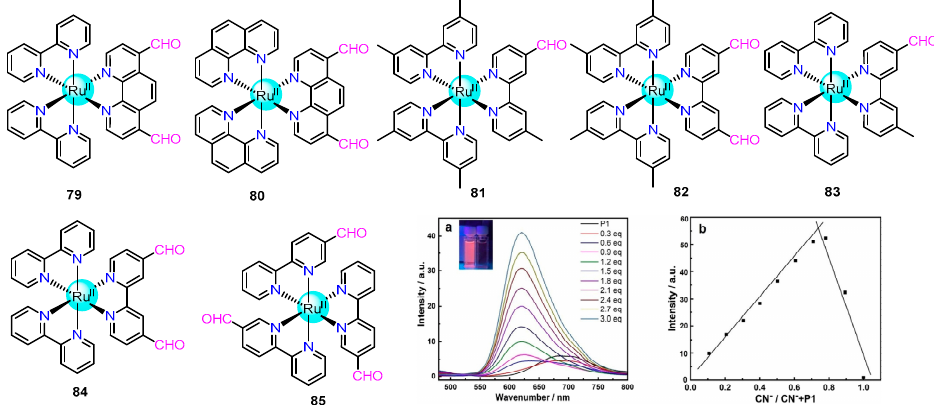
Figure 13. Structures of Aldehyde group containing Ru(II) complexes 81 – 84 . ( a ) phosphorescence titration of 85 with CN − (0.3 eq/time) (inset left: 85 , right: 85 + 3CN – ). ( b ) Job's plots of CN − adduct complexes of 85. [Adapted from reference [109]; Copyright © 2023, Royal Society of Chemistry] .